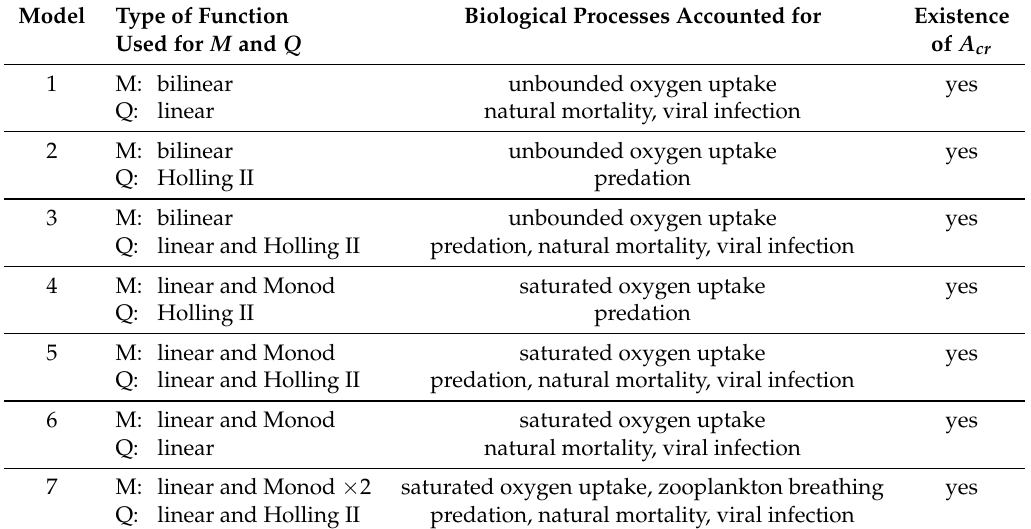
Table 1. Summary of the biological factors accounted for and of the types of nonlinear responses used in Models